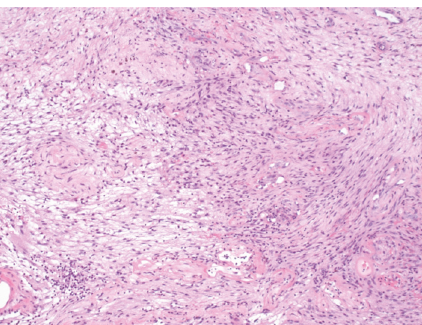
Figure 2: Ultrasound of the left adnexal mass in transview.